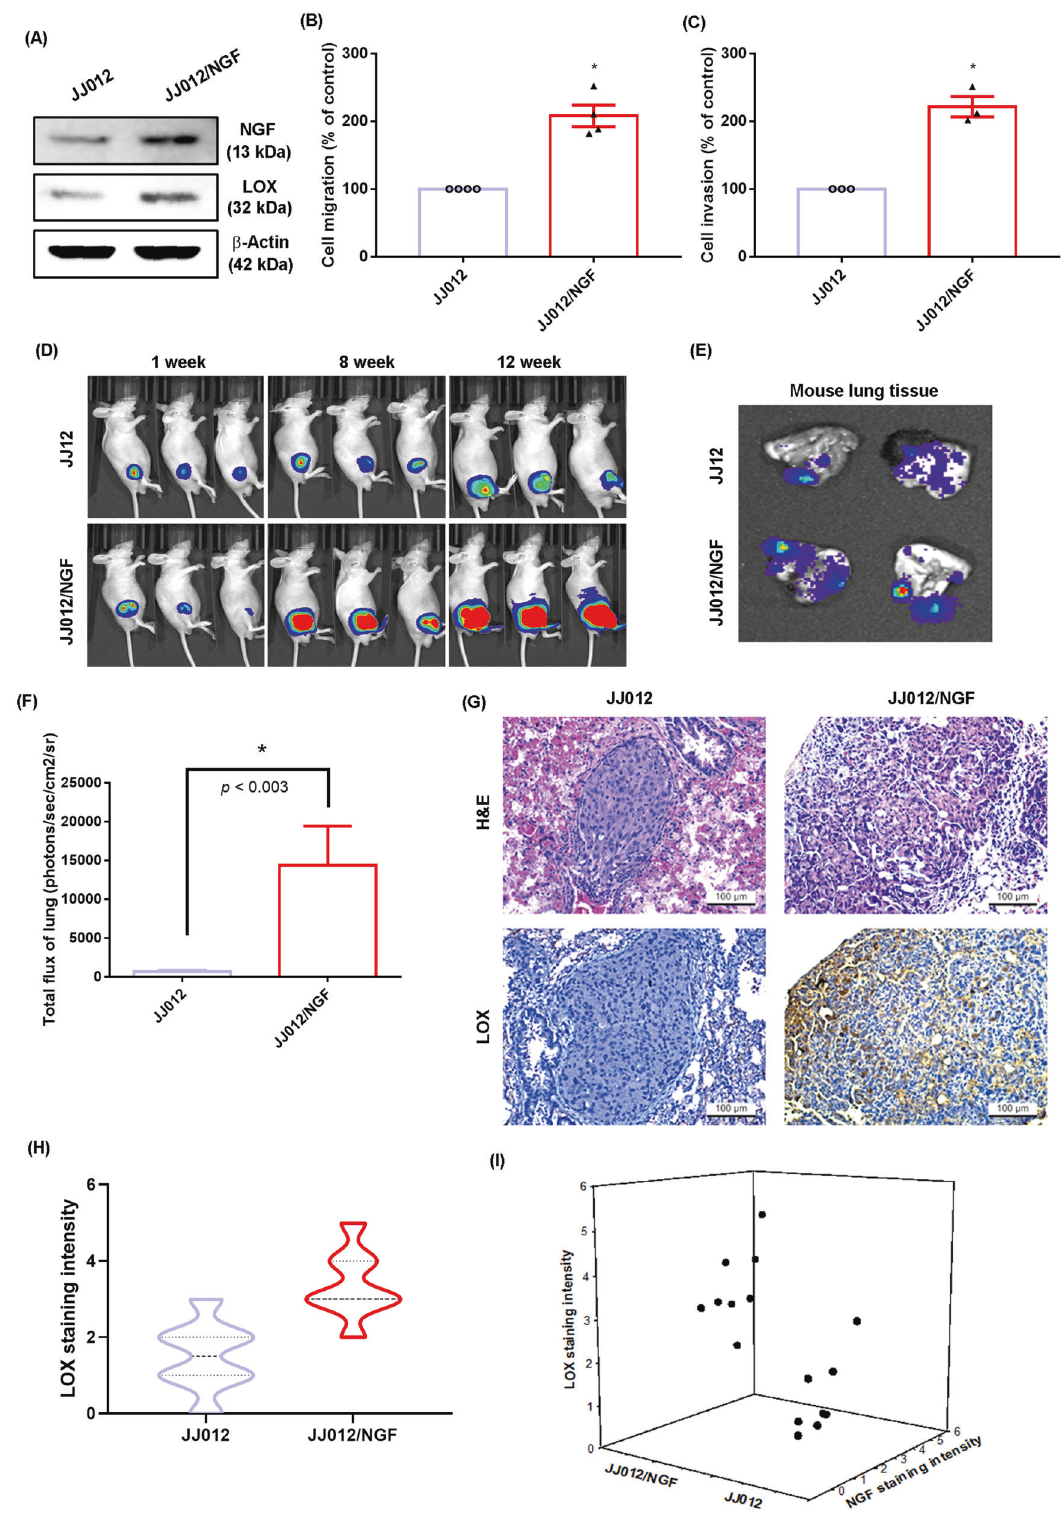
Fig. 6 NGF promotes chondrosarcoma metastasis to lungs in vivo. A – C NGF and LOX levels, as well as the migratory ability of JJ012 and JJ012/NGF cells, were examined by western blot and Transwell. D The mice were injected with JJ012 or JJ012/NGF cells. Lung metastasis was monitored by bioluminescence imaging at the indicated time intervals, and then quanti fi ed by photon images. E , F After 12 weeks, the mice were humanely sacri fi ced and the lung tissue was excised, photographed, and quanti fi ed. G , H Levels of LOX expression in lung tumors were subjected to IHC analysis. I The positive correlation between NGF and LOX protein expression was observed in mice lung tissue. * p < 0.05 compared with the JJ012 group.